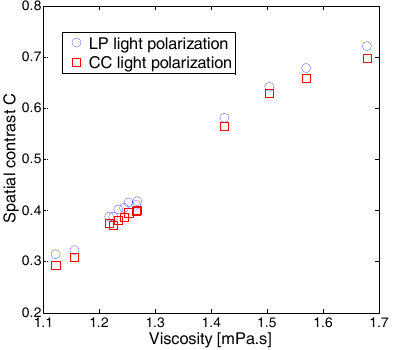
Figure 4. Variation of the speckle spatial contrast C as a function of white wine viscosity. Standard deviations are approximately ± 0.001 mPa.s for the viscosity, and ± 0.002 for the contrast C. Error bars are not displayed on the figures for the sake of clarity.